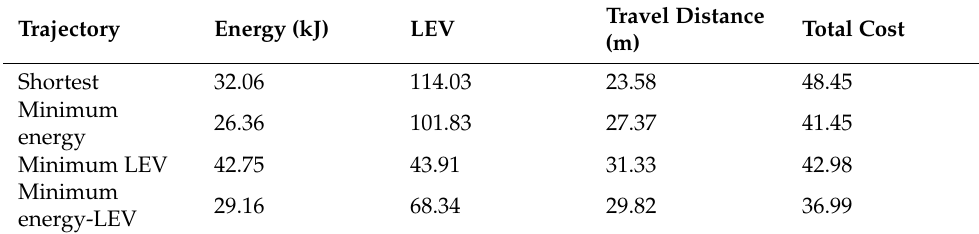
Table 5. Simulation results in case